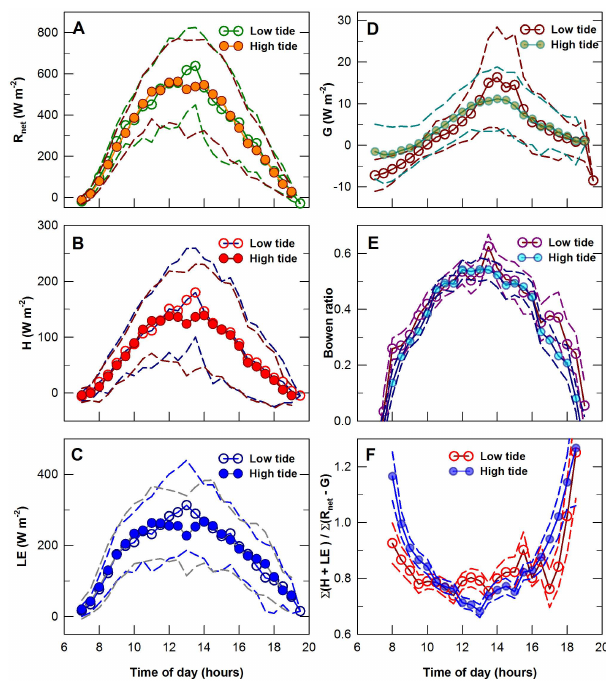
Fig. 3. Mean daily trend (solid lines) ± 1s.d. (dashed lines) of net radiation ( R net ; A ), sensible ( H ; B ) and latent (LE; C ) heat fluxes, soil heat flux ( G ; D ), Bowen ratio ( E ), and energy balance closure ( 6(H + LE )/6(R net − G ); F ) during July to September 2004 and July to August 2005. Flux data were partitioned into periods when the sediment was exposed (low tide) and when the surface was in- undated (high